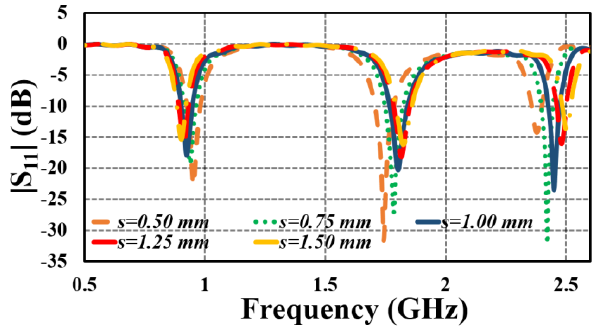
Figure 4: |S 11 | dB variation versus frequency for different slit width ( s ).